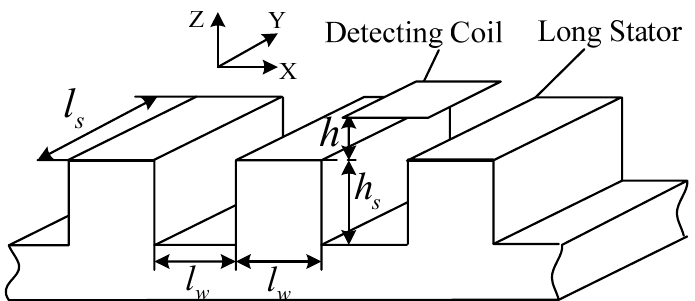
Figure 4. The coil-stator